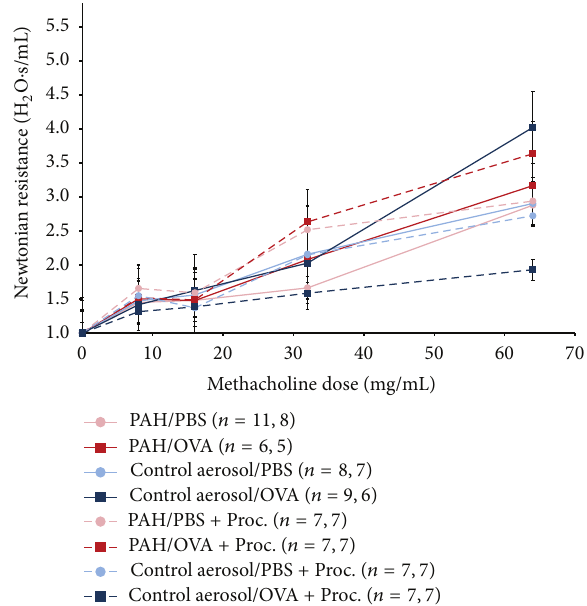
Figure 3: AHR following prenatal PAH exposure in the presence and absence of procaterol (Proc). Newtonian resistance (H 2 O/s/mL) was normalized to value measured following PBS aerosol exposure. Total sample size, followed by sample size for mice that completed highest dose, is listed in